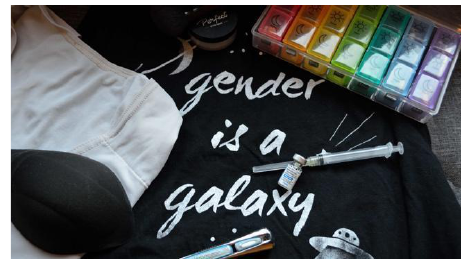
Figure 6. “Tools of the Trade”